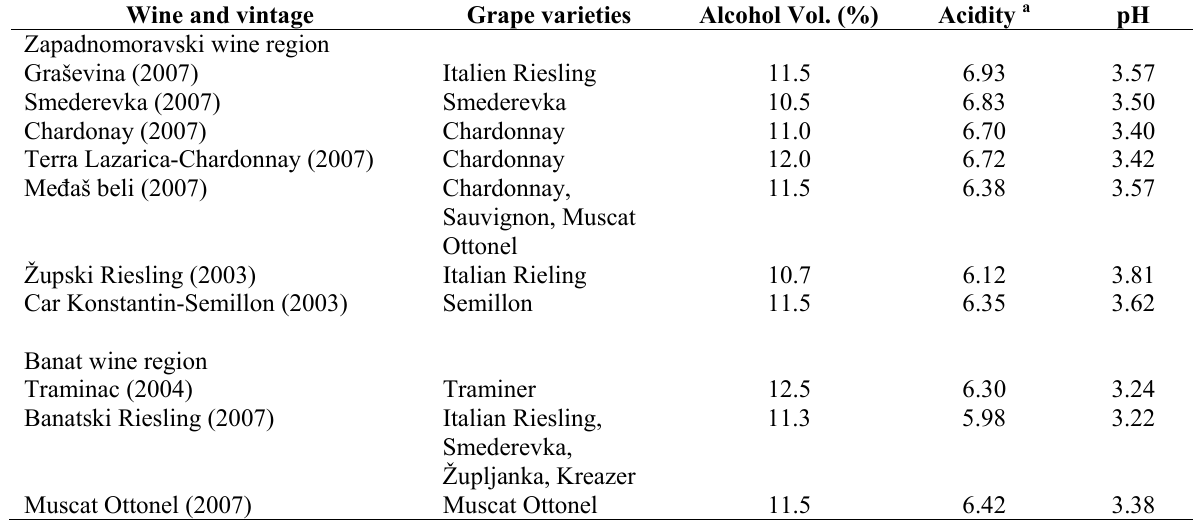
Table 6. Compositional factors determined in the white